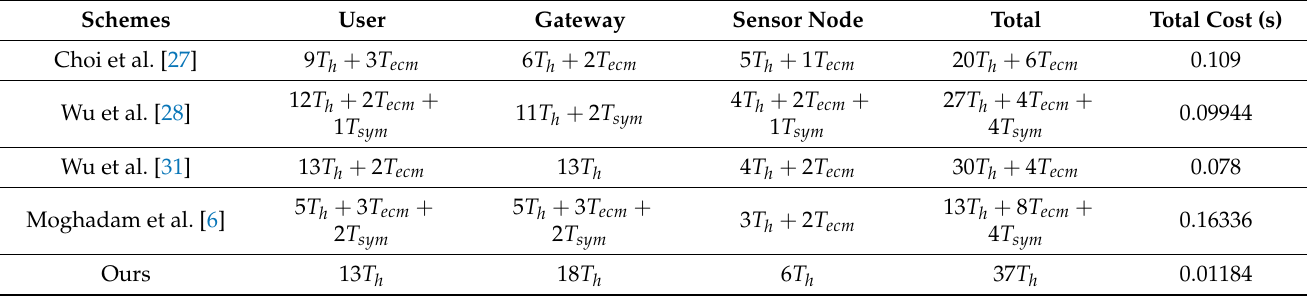
Table 3. Computational costs